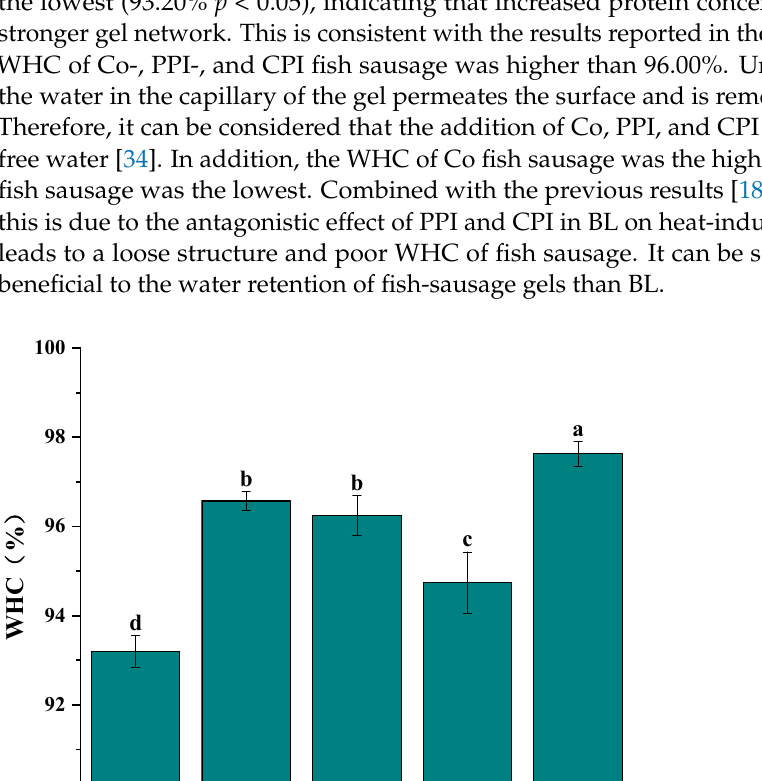
Figure 2. Effects of different protein pre-emulsified soybean oils on the cooking loss of fish sausage. Note: Different letters indicate that there is a significant difference between samples ( p < 0.05). The error bars represent the standard deviation ( n = 3).